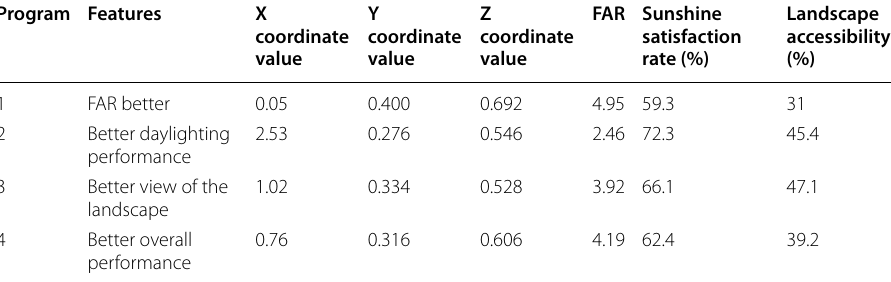
Table 5 Four sets of programs and performance target values Program